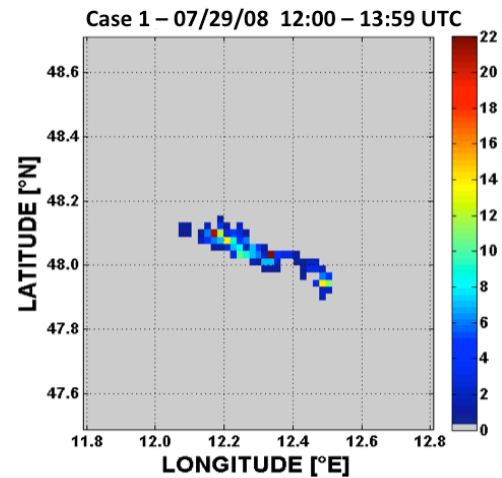
Fig. 7. Cumulated total strokes (IC + CG) registered by the LINET network over the Munich area (Case 1) between 12:00 and 13:59 UTC, 29 July 2008. The horizontal resolution is 2 × 2km 2 . The different colors show the total events registered for each pixel.